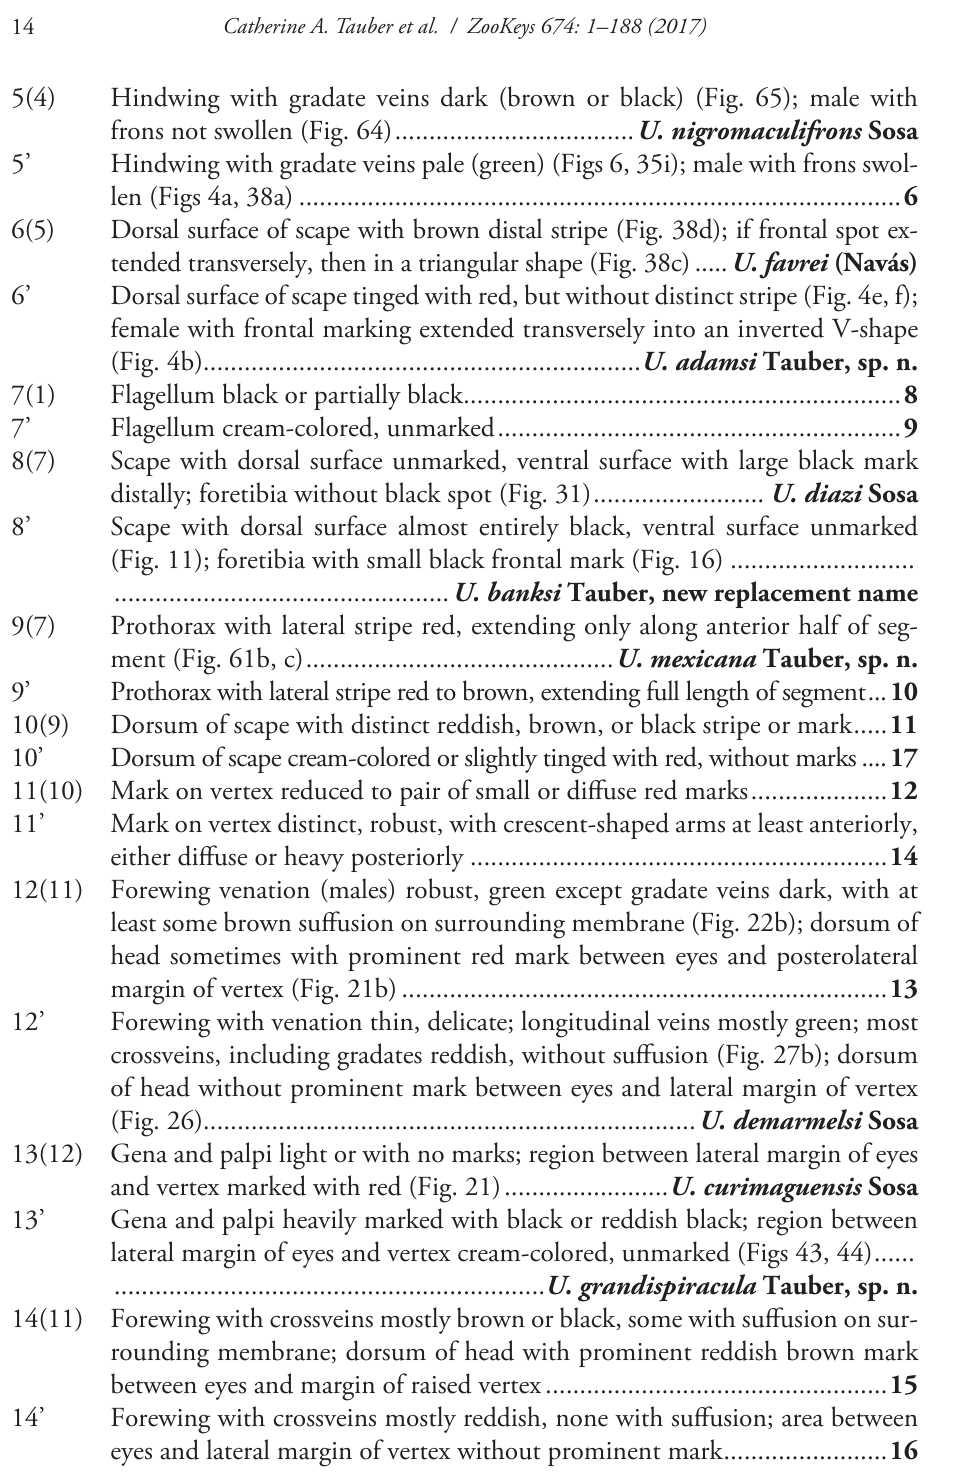
Hindwing with gradate veins dark (brown or black) (Fig. 65); male with 5’ Hindwing with gradate veins pale (green) (Figs 6, 35i); male with frons swol- len (Figs 4a, 38a) ........................................................................................ 6 6(5) Dorsal surface of scape with brown distal stripe (Fig. 38d); if frontal spot ex- tended transversely, then in a triangular shape (Fig. 38c) ..... U. favrei (Navás) 6’ Dorsal surface of scape tinged with red, but without distinct stripe (Fig. 4e, f); female with frontal marking extended transversely into an inverted V-shape 7(1) 7’ 8(7) Scape with dorsal surface unmarked, ventral surface with large black mark distally; foretibia without black spot (Fig. 31) ......................... U. diazi Sosa 8’ Scape with dorsal surface almost entirely black, ventral surface unmarked (Fig. 11); foretibia with small black frontal mark (Fig. 16) ........................... 9(7) Prothorax with lateral stripe red, extending only along anterior half of seg- ment (Fig. 61b, c) ............................................. U. mexicana Tauber, sp. n. 9’ Prothorax with lateral stripe red to brown, extending full length of segment ... 10 10(9) Dorsum of scape with distinct reddish, brown, or black stripe or mark ..... 11 10’ Dorsum of scape cream-colored or slightly tinged with red, without marks .... 17 11(10) Mark on vertex reduced to pair of small or diffuse red marks .................... 12 11’ Mark on vertex distinct, robust, with crescent-shaped arms at least anteriorly, either diffuse or heavy posteriorly ............................................................. 14 12(11) Forewing venation (males) robust, green except gradate veins dark, with at least some brown suffusion on surrounding membrane (Fig. 22b); dorsum of head sometimes with prominent red mark between eyes and posterolateral margin of vertex (Fig. 21b) ....................................................................... 13 12’ Forewing with venation thin, delicate; longitudinal veins mostly green; most crossveins, including gradates reddish, without suffusion (Fig. 27b); dorsum of head without prominent mark between eyes and lateral margin of vertex (Fig. 26)........................................................................ U. demarmelsi Sosa 13(12) Gena and palpi light or with no marks; region between lateral margin of eyes and vertex marked with red (Fig. 21) ........................ U. curimaguensis Sosa 13’ Gena and palpi heavily marked with black or reddish black; region between lateral margin of eyes and vertex cream-colored, unmarked (Figs 43, 44) ...... 14(11) Forewing with crossveins mostly brown or black, some with suffusion on sur- rounding membrane; dorsum of head with prominent reddish brown mark between eyes and margin of raised vertex .................................................. 15 14’ Forewing with crossveins mostly reddish, none with suffusion; area between eyes and lateral margin of vertex without prominent mark ........................